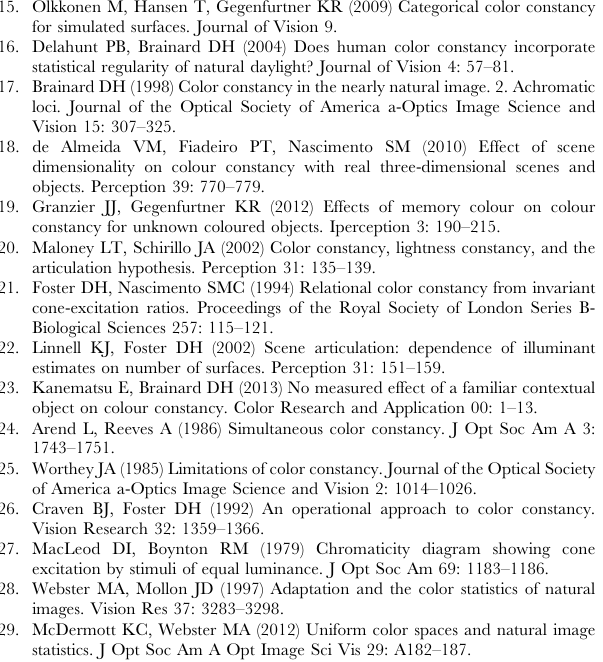
Figure S2 Scene statistics from the grey background condition. A. top: Surface reflectance function of the grey background material (in blue) with .05 line marked (dashed line); below: Plots of relative spectral power for each of the four extreme metamer spectra: bluer, yellower, greener and redder, respectively. B. Maximum, mean, skewness and kurtosis values for cone- opponent contrast channel changes between D67 and the bluer, redder, greener and yellower illuminations at each D E uv comparison in the grey background condition, in modified MacLeod-Boynton (McB) coordinates. (TIFF) Figure S3 Chromaticity co-ordinates of 95 patches from the Mondrian background condition (top) and grey background condition (bottom) under D67 illumination. The first principal components are marked with solid lines (slopes of 0.93 and 2 1.08, respectively); blue lines indicate the blue-yellow variation direction, and green lines the red-green variation direction, respectively. The greatest variance occurs along the blue-yellow direction in the Mondrian background, and along the red-green direction for the grey background. (TIFF) Table S1 CIE 1931 xy chromaticity coordinates of readings of the 34 illuminations used in the experiment, for the two loci. Table S2 CIE 1931 xy chromaticity coordinates of the fruit and matched printed papers used in the experi- ment, measurements taken under